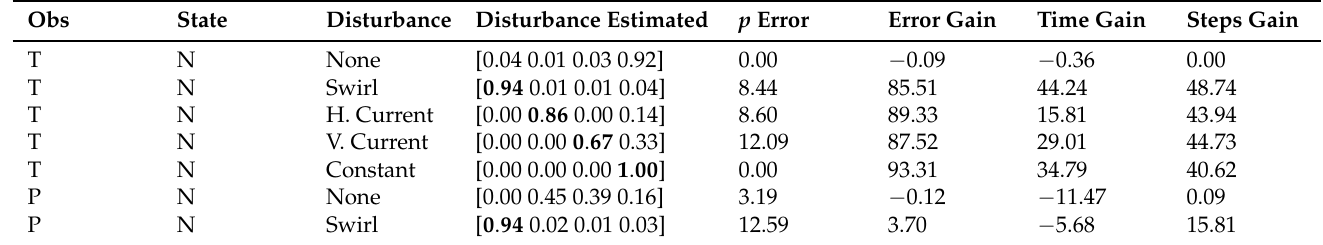
Figure 2. Sample trajectories obtained for different disturbances. In black, we have the disturbance field, the green point is the starting position, and the green star (center) is the target. In all cases, we consider partial observability and use a Kalman filter for state estimation, as well as our proposed transition and disturbance estimator. In red, we show results for the CDE, whereas dashed blue is for the FDE: the differences are only notable on the swirl case, which is consistent with the results shown in Table 3. Note that horizontal and vertical current trajectories look alike, but are different. Table 1. FDE results, where observation is total (T) or partial (P), and the state estimator used is none (N) or a Kalman filter (KF). For each disturbance, we show the proportion of times that the disturbance estimator detected it as a [Swirl, Horizontal Current, Vertical Current, Constant Field], and in bold, we highlight the highest proportion. Note that, in all cases, the true disturbance is the one detected the highest number of times. For all gains, higher is